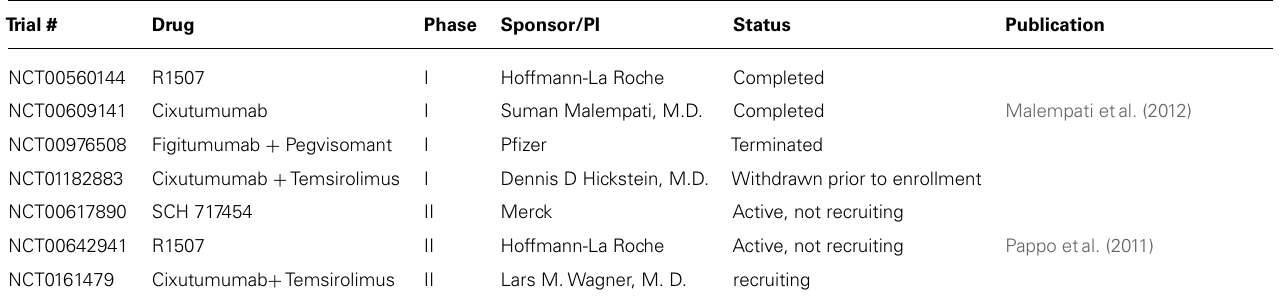
Table 2 | Clinical trials with IGF-1R antagonists including pediatric